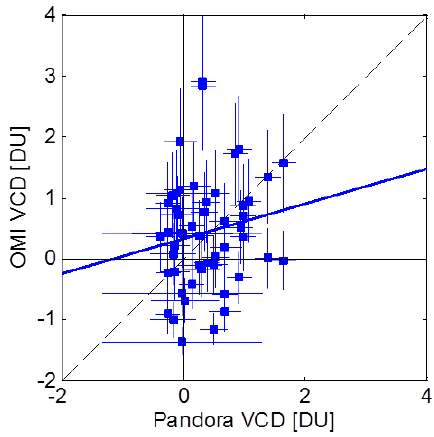
Figure 12. A scatter plot of SO 2 VCD values measured by the OMI satellite instrument and Pandora. The correlation coefficient between the two data sets is 0.17 and the slope of the regression line is 0.23. The error bars represent 2 σ